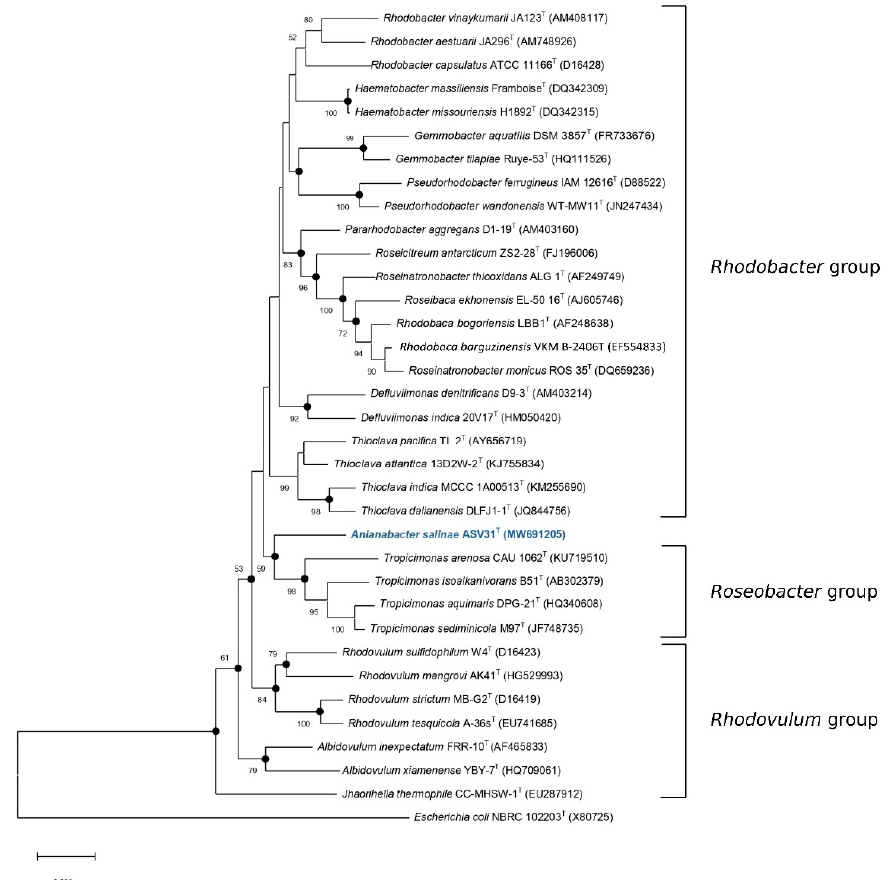
Figure 1. Neighbour-joining phylogenetic tree based on 16S rRNA gene sequences that shows the relationship between strain ASV31 T and the type strains of Rhodobacter , Roseobacter and Rhodovulum groups of the family Rhodobacteraceae . The black circles indicate the clades that were also conserved in both the maximum-likelihood and minimum-evolutionary phylogenetic trees. Bootstrap values (expressed as percentages of 1000 replications) greater than 50% in the clade nodes are shown. Escherichia coli NCCB 54008 T was used as outgroup. Scale: 0.02 substitutions per nucleotide position.